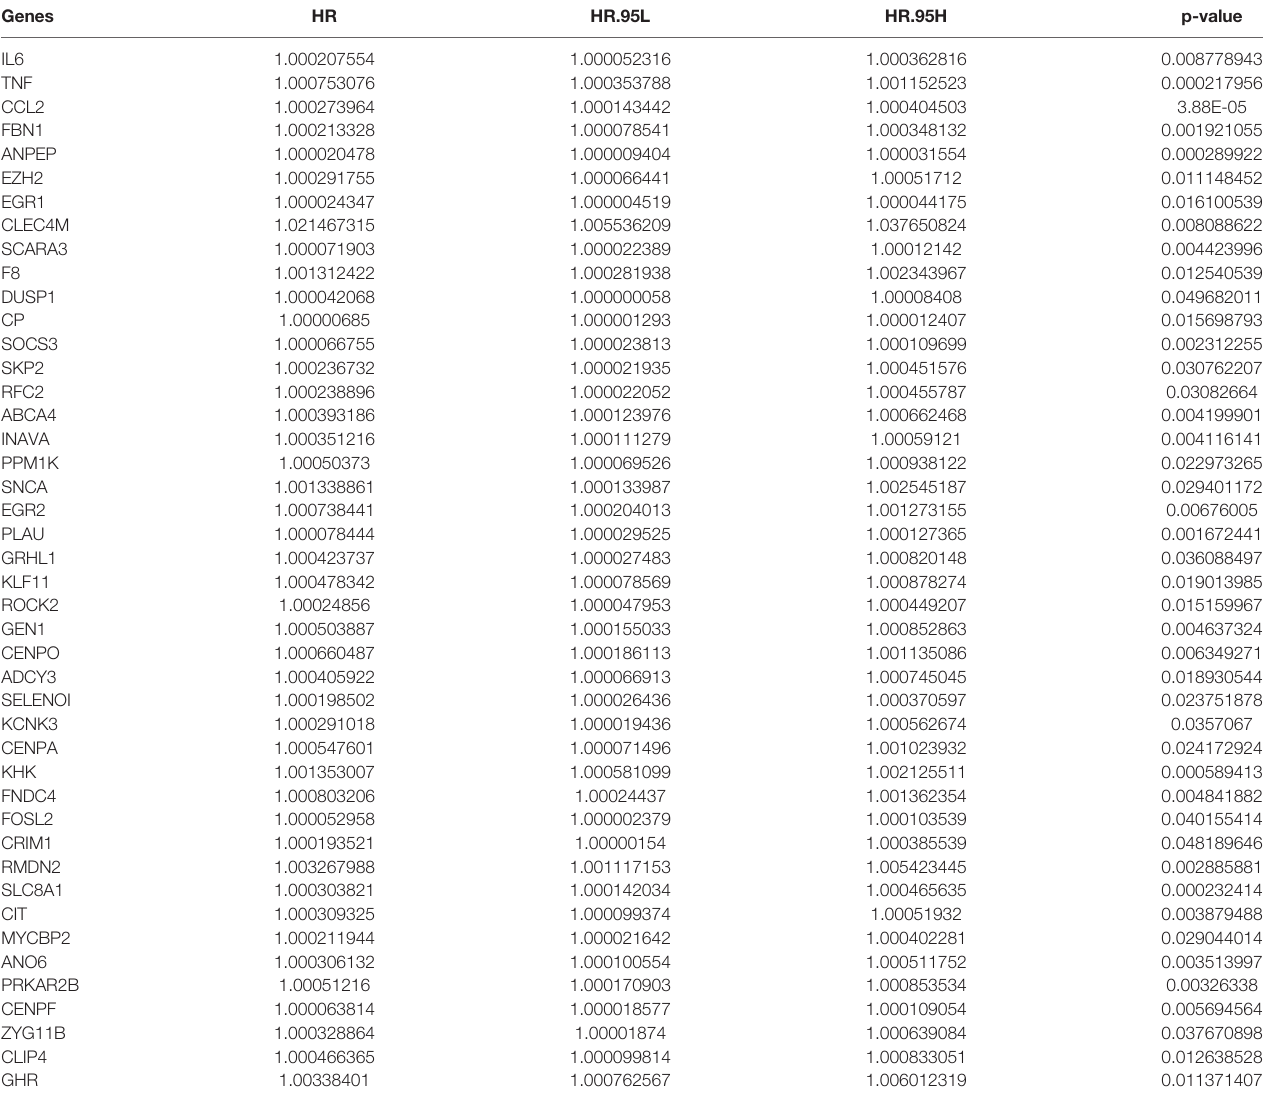
TABLE 1 | Univariate cox proportional hazards regression analysis of COVID-19_UCEC gene.